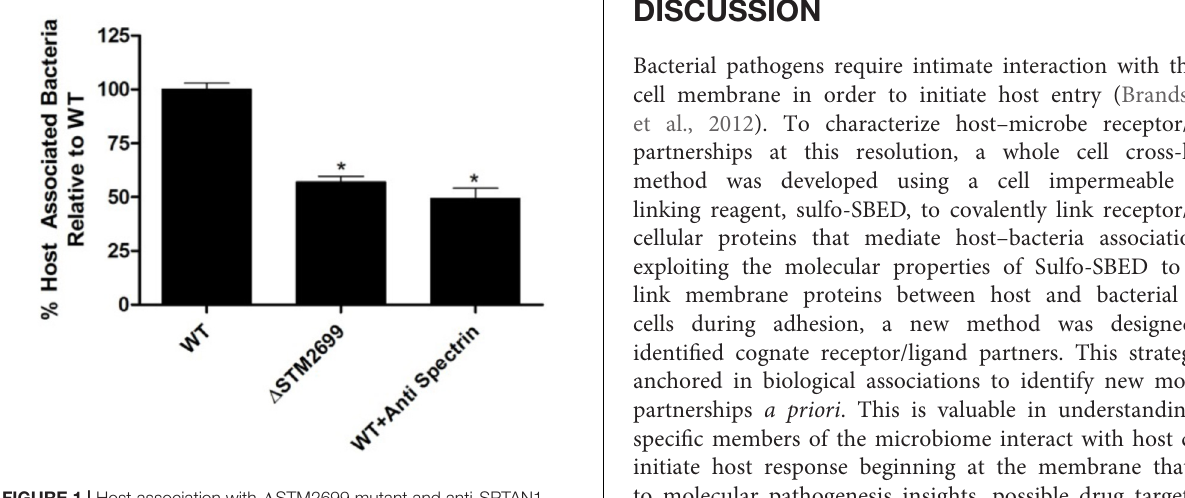
FIGURE 1 | Host association with (cid:49) STM2699 mutant and anti-SPTAN1 antibody blocking. The amount of total host associated Salmonella in vitro . A significant reduction in adhesion ( p < 0.05) between the wild type (WT) and treatment is indicated with “ ∗ ”. The error bars represent standard error of the mean from four biological